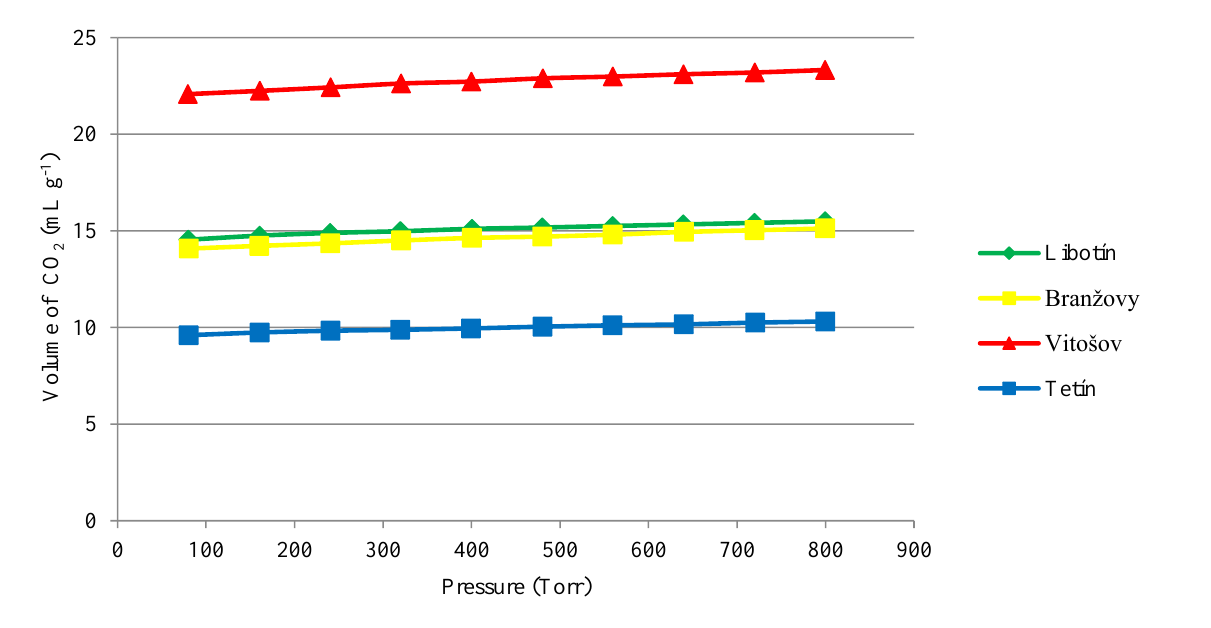
Figure 9. Volume of carbon dioxide used for physisorption.